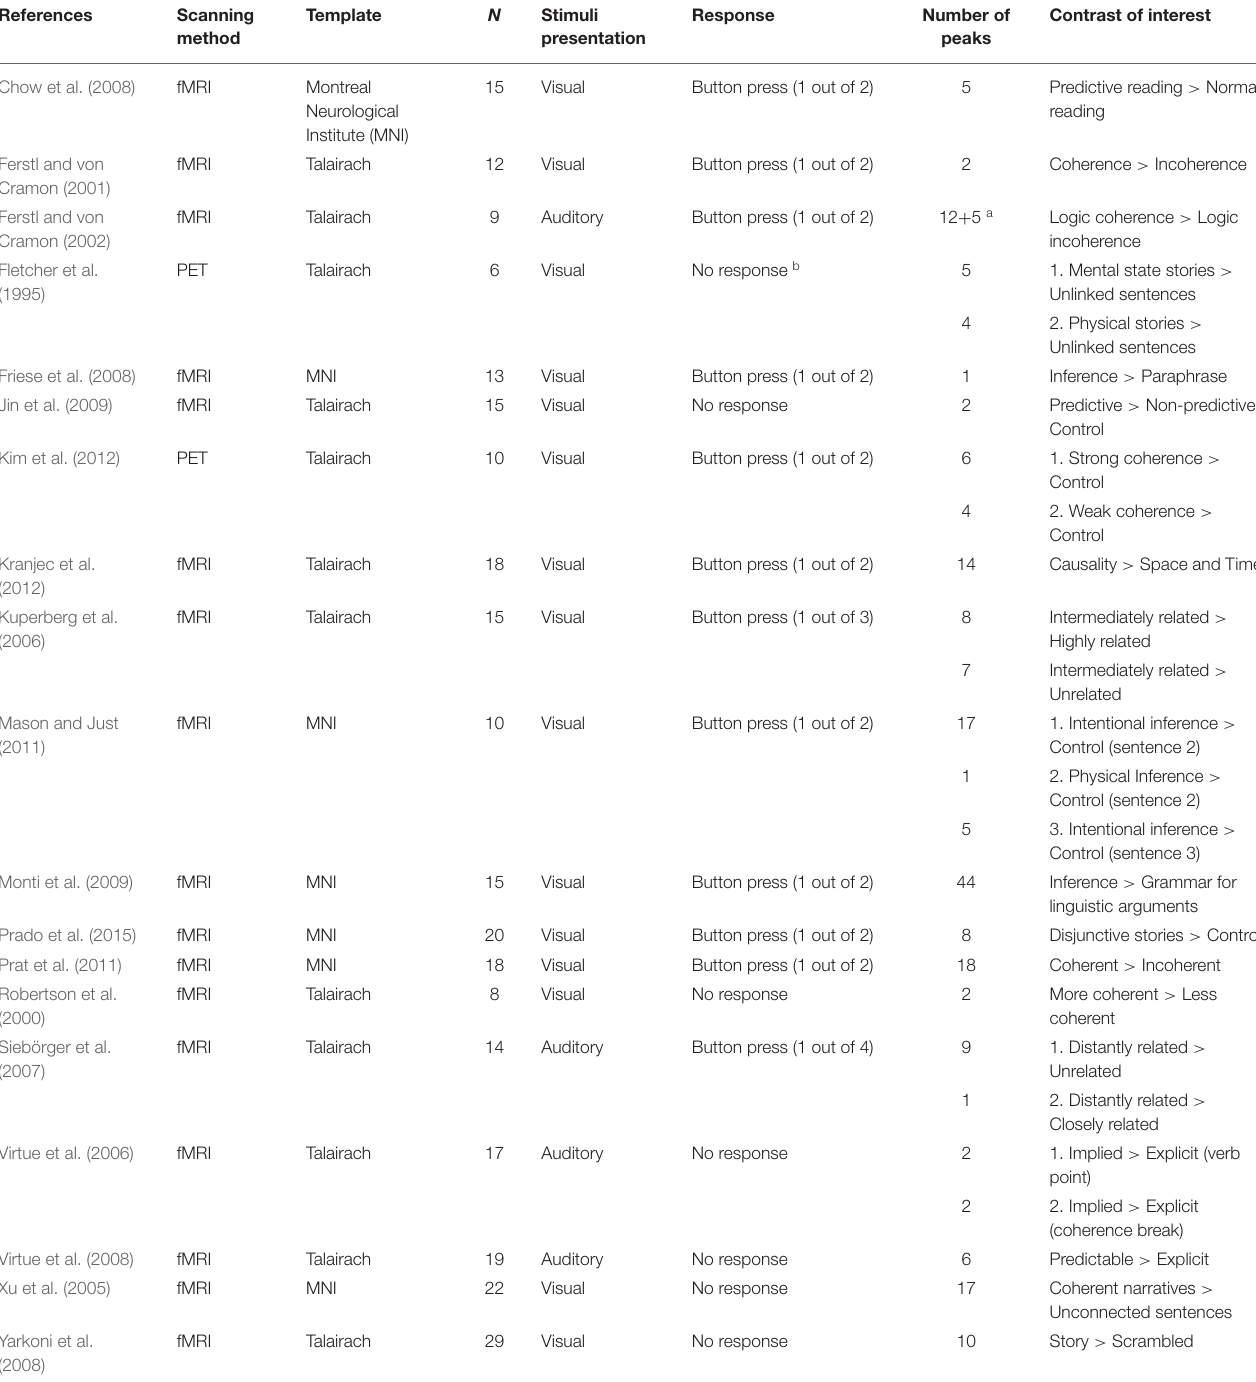
TABLE 2 | Studies on the discourse inferences that were included in the